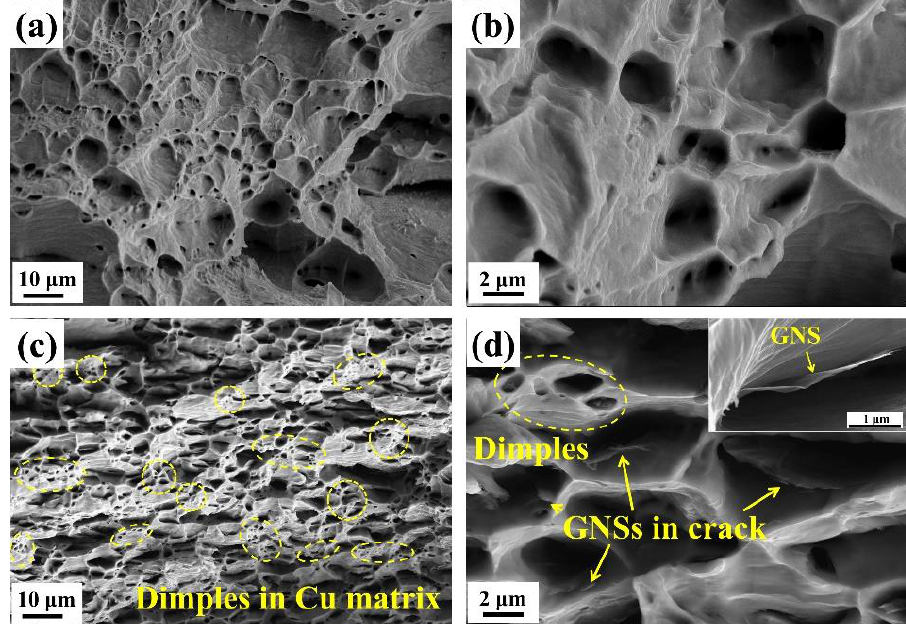
Figure 5. Fracture surface of ( a ) and ( b ) pure Cu and ( c ) and ( d ) GNS/Cu laminated composite (the yellow arrows indicate GNS inside the dimples).